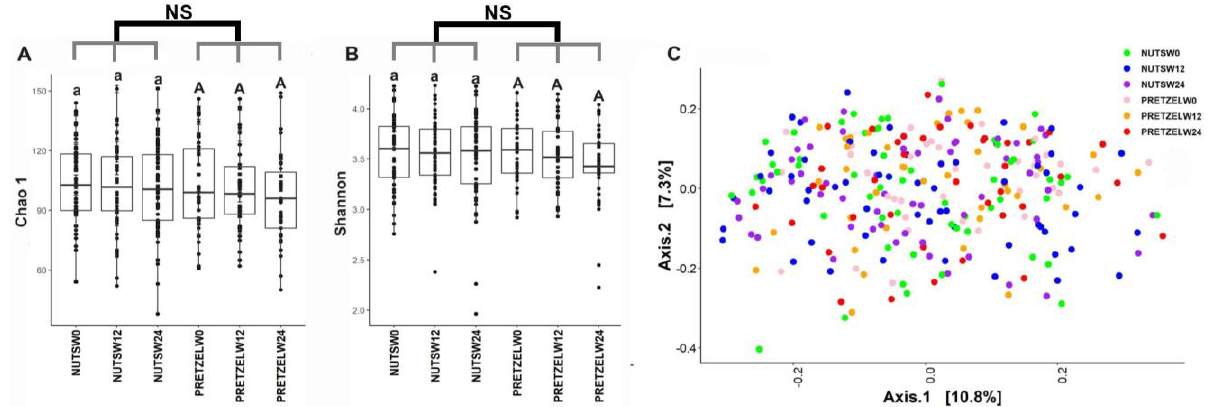
Figure 4. Gut microbiome diversity analysis. Alpha diversity indexes ( A ) Chao 1 and ( B ) Shannon and ( C ) principal coordinate analysis plot of β -diversity measure Bray–Curtis dissimilarity plot of all fecal samples from pretzel group ( n = 39) and MTNs group ( n = 56) collected at baseline (PRETZELW0, NUTSW0), week 12 (PRETZELW12, NUTSW12), and week 24 (PRETZELW24, NUTSW24). For within-group analysis of alpha diversity (lower case for MTNs; upper case for pretzels), means in a column without a common letter differ, p < 0.05). Changes from baseline were analyzed and no between-groups significant difference (NS) was detected.